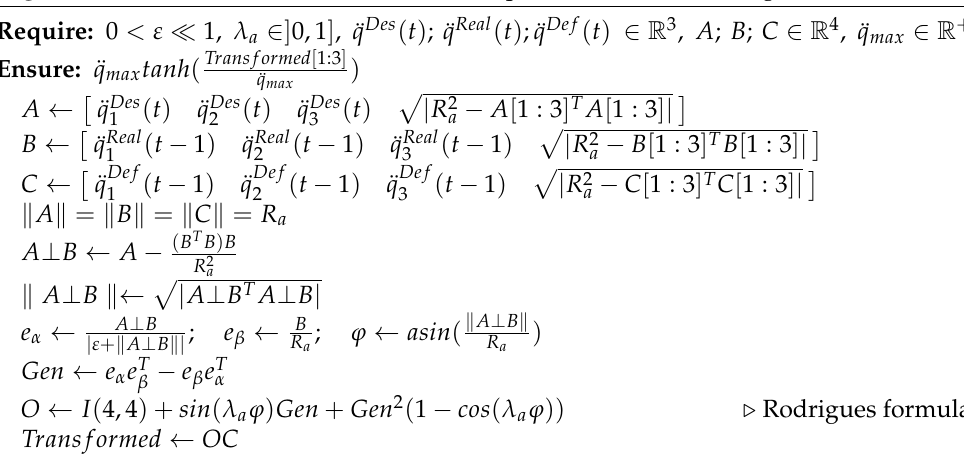
Algorithm 1 The abstract rotation-based fixed point transformation